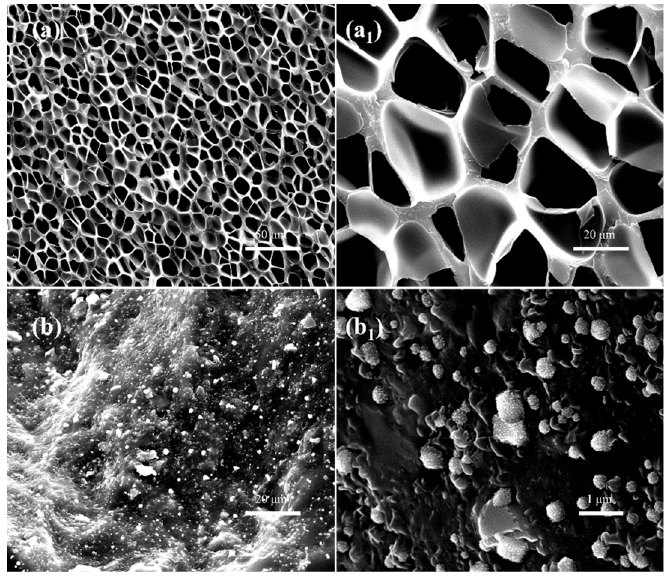
Figure 5. SEM images of neat SAN ( a , a 1 ) and neat CPE ( b , b 1 ) after rapid depressurization foaming treatment at 135 °C and 20 MPa.